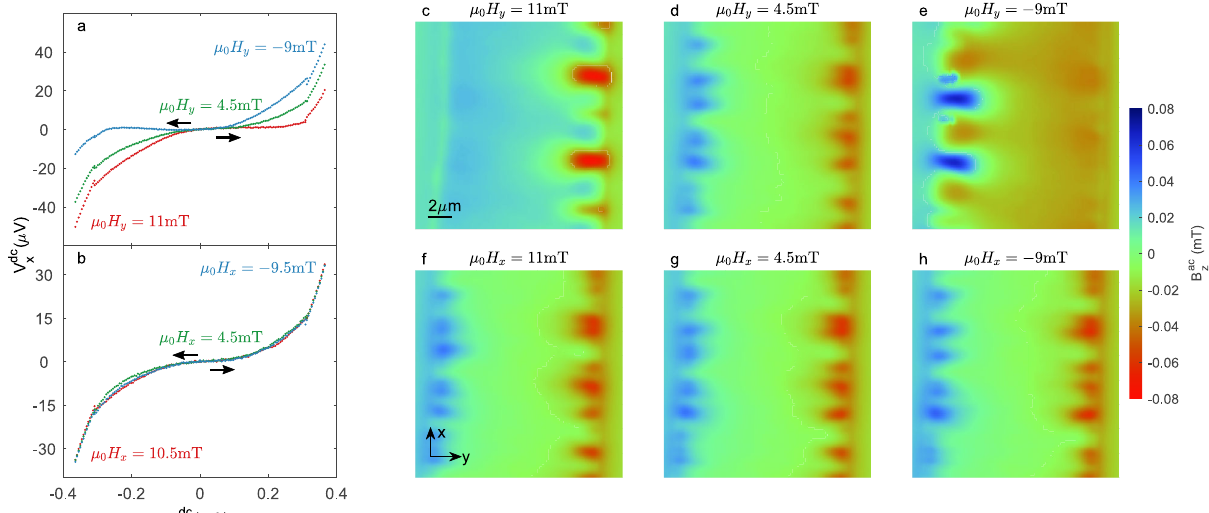
Fig. 2 | Vortex fl ow and corresponding transport measurements as a function of an applied in-plane magnetic fi eld. a , b I ( V ) characteristics for different transverse ( a )and longitudinal( b ) magnetic fi elds;arrows indicate the direction of thecurrentsweep.Theredandbluecurvesareat fi eldsbeyondthesaturation fi eld ( H s ), while the green curve is at the coercive fi eld. Black arrows indicate that the transport curves were always swept from zero to maximum bias in order to elim- inate the effect of hysteresis caused by heating. c – h SQUID-on-tip (SOT) image of the ac out-of-plane component of the magnetic fi eld B ac z ð x , y Þ modulated with respecttoanoscillatingtransportcurrentwithanRMSvalue I ac x ’ 0 : 42mA> I c .The